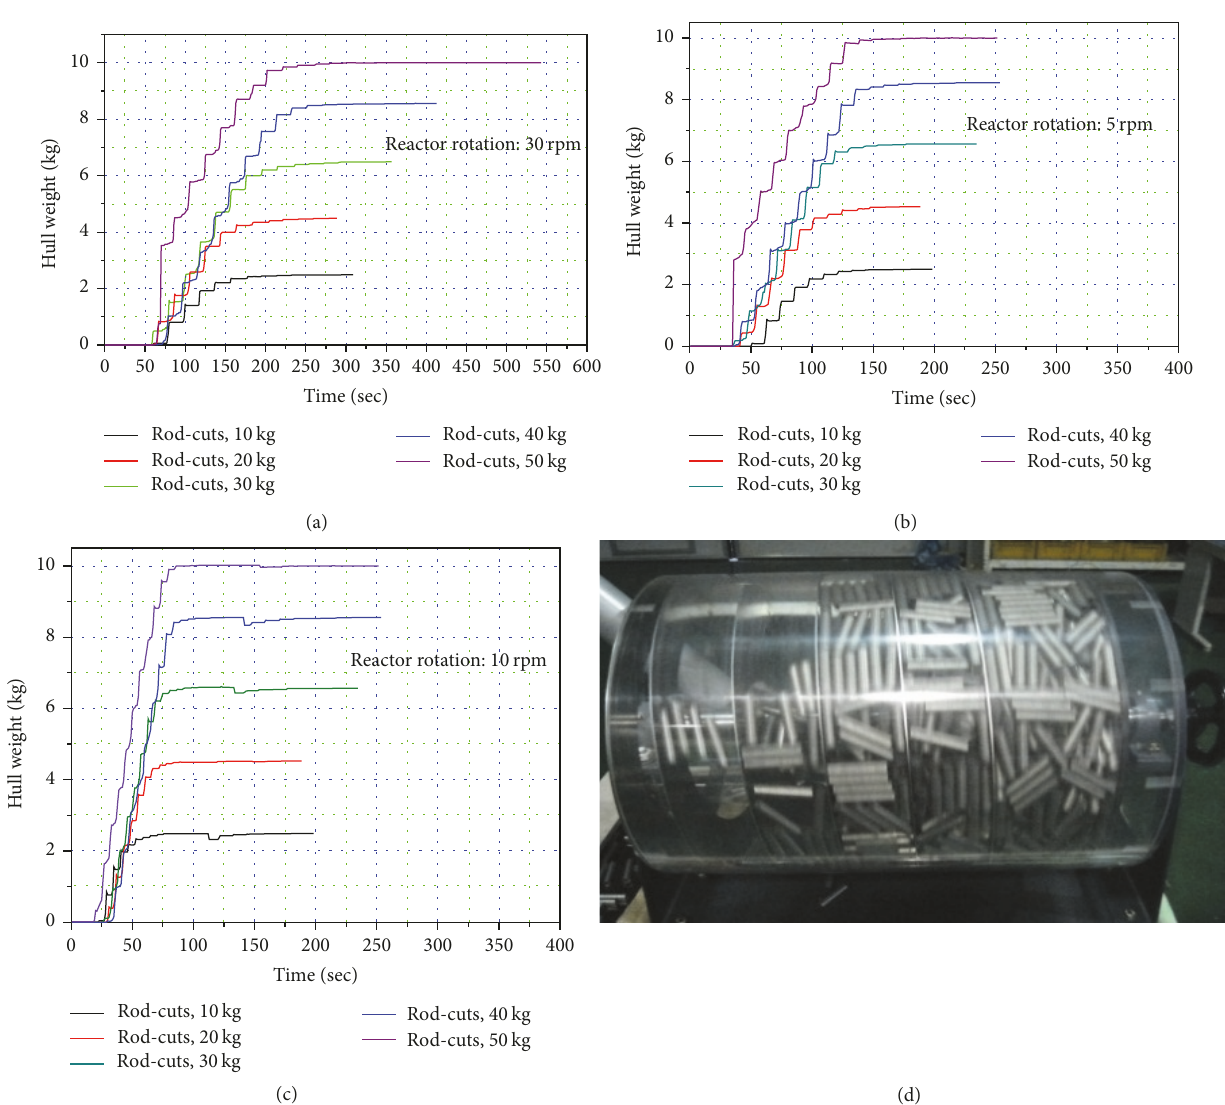
Figure 20: Hull recover ratio as a function of hull weight and reactor rotation of (a) 3 rpm, (b) 5rpm, (c) 10 rpm, and (d) 20rpm.